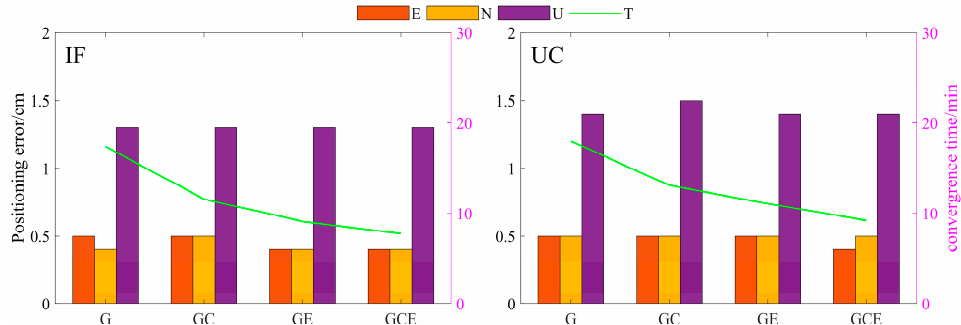
Figure 12. The RMS results of positioning error and convergence time of the IF model ( left ) and the UDUC model ( right ) G, GE, GC, and GCE static PPP-AR on DOY 300–306, 2021, for 22 stations.